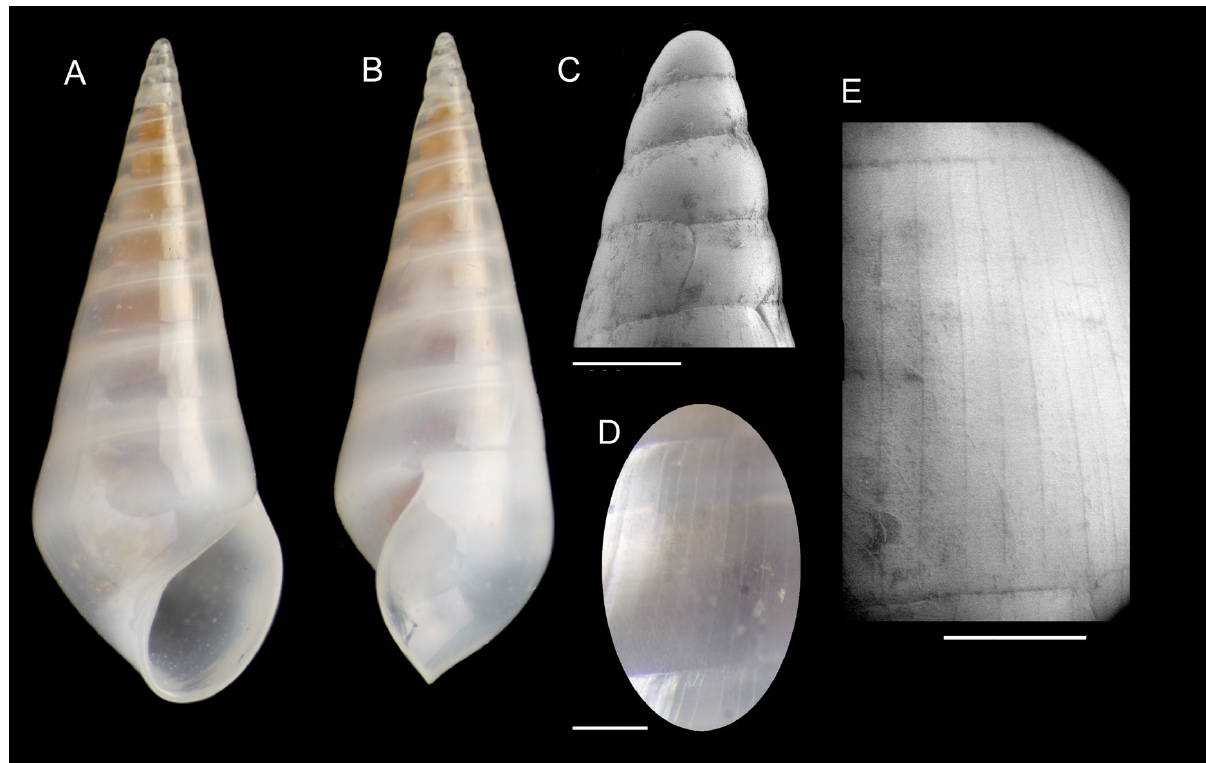
Fig. 6. – Holotype of Melanella scarifata Gofas and Rueda, n. sp. (height 5.1 mm). A: apertural view. B: view showing the profile of the outer lip. C: protoconch, ESEM micrograph; note the flexuous scar demarcating protoconch from teleoconch. D: detail of the microsculpture under the optical stereomicroscope. E: ESEM micrograph of the microsculpture (scale bars are 200